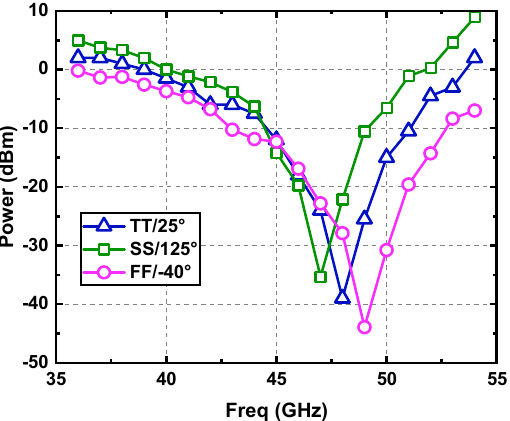
Figure 13. Simulated sensitivity curves of the frequency divider.